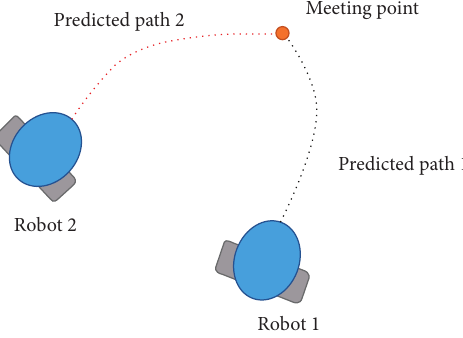
Figure 5: The model of